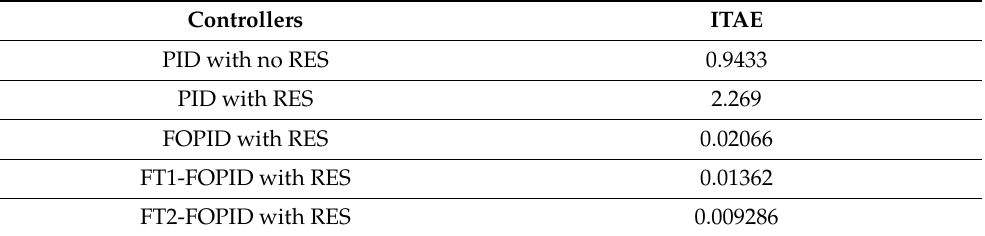
Table 3. ITAE results obtained for various controllers for demand change of 1% in Area 1.